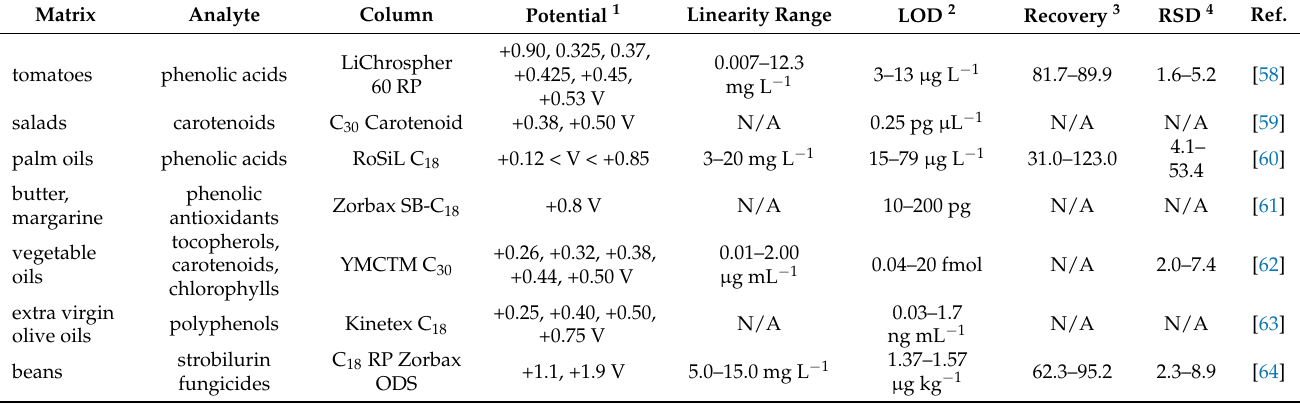
Table 3 resumes the data reported in this section. Table 3. HPLC-ED analysis performance in the analysis of different compounds in oils, seeds and vegetables matrices. The term “N/A” means the information is absent in the